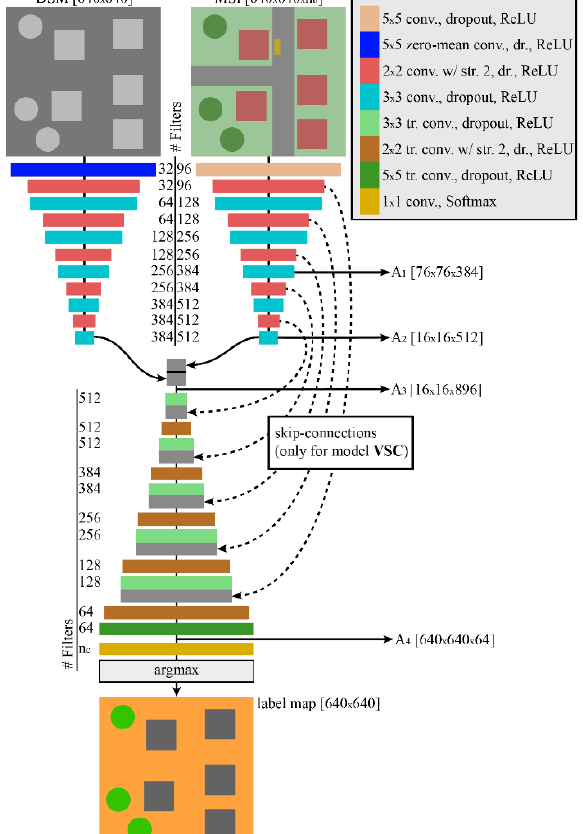
Figure 1: Proposed FCN structure. A 1 – A 4 : layers used for DA in our experiments (cf. Sections 4 and